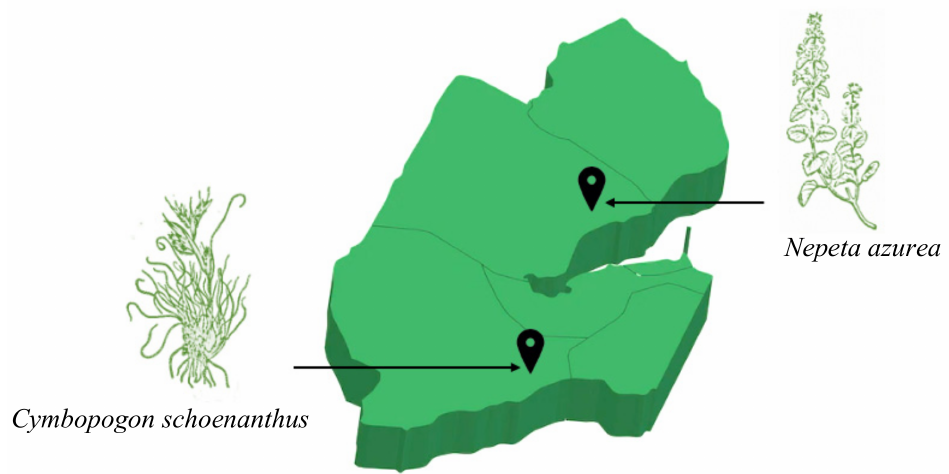
Figure 1. Harvest locations of two species: Cymbopogon schoenanthus and Nepeta azurea in the Republic of